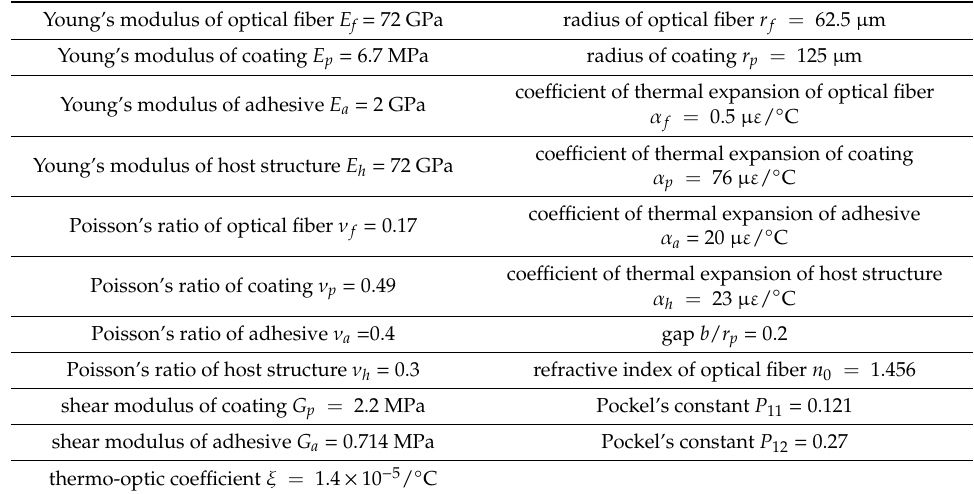
coe ffi cient of thermal expansion of optical fiber ◦ C α f = 0.5 µε / coe ffi cient of thermal expansion of coating ◦ C α p = 76 µε / coe ffi cient of thermal expansion of adhesive α = 20 µε / ◦ C a coe ffi cient of thermal expansion of host structure ◦ C α h = 23 µε /